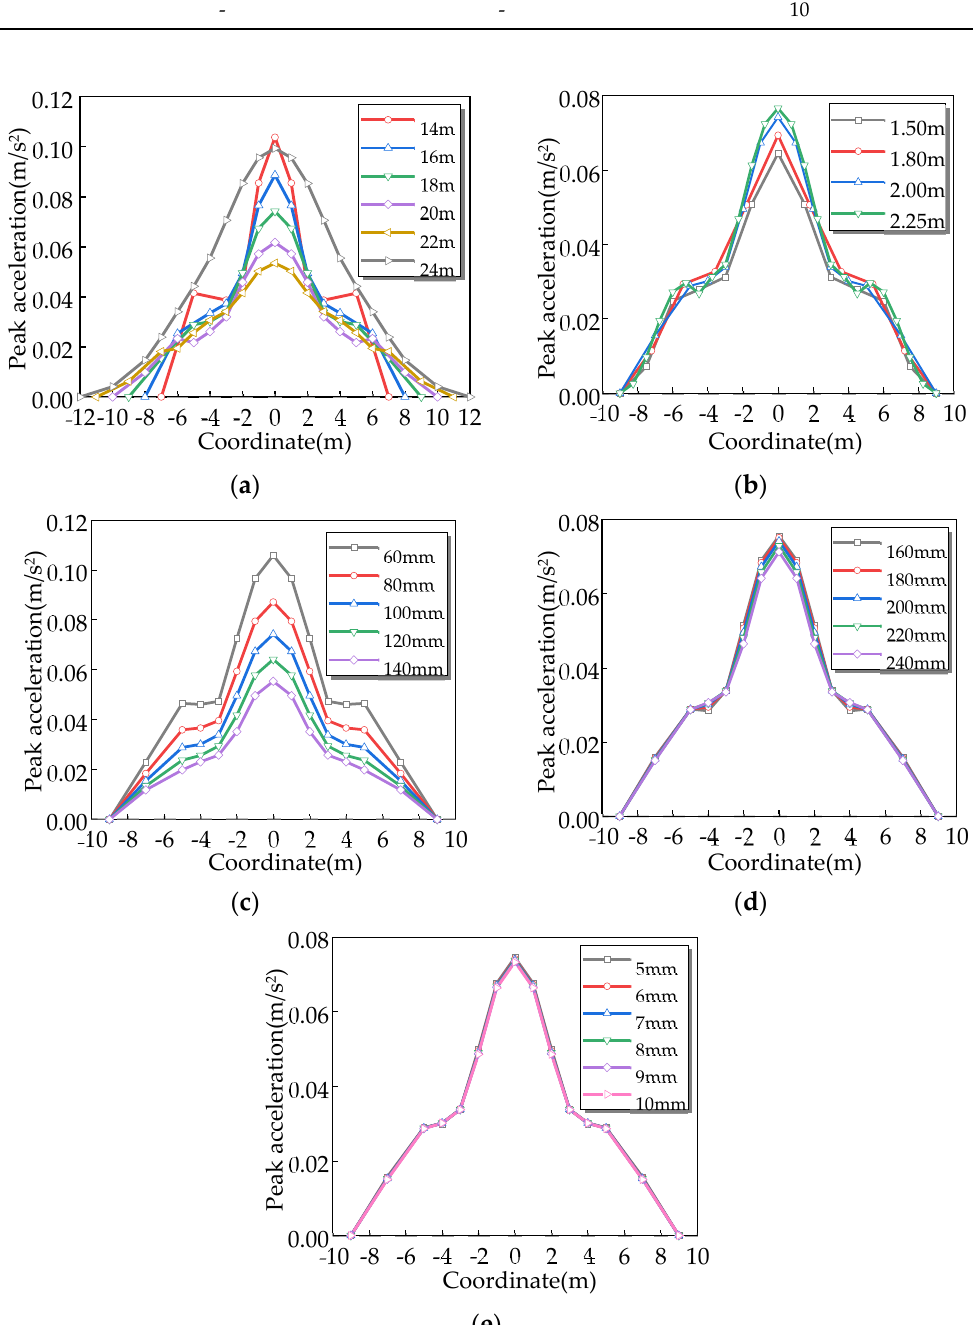
Figure 14. Effect of structural parameters on peak acceleration response: ( a ) effect of floor span; ( b ) effect of grid size; ( c ) effect of concrete slab thickness; ( d ) effect of chord height; ( e ) effect of shear connector thickness.